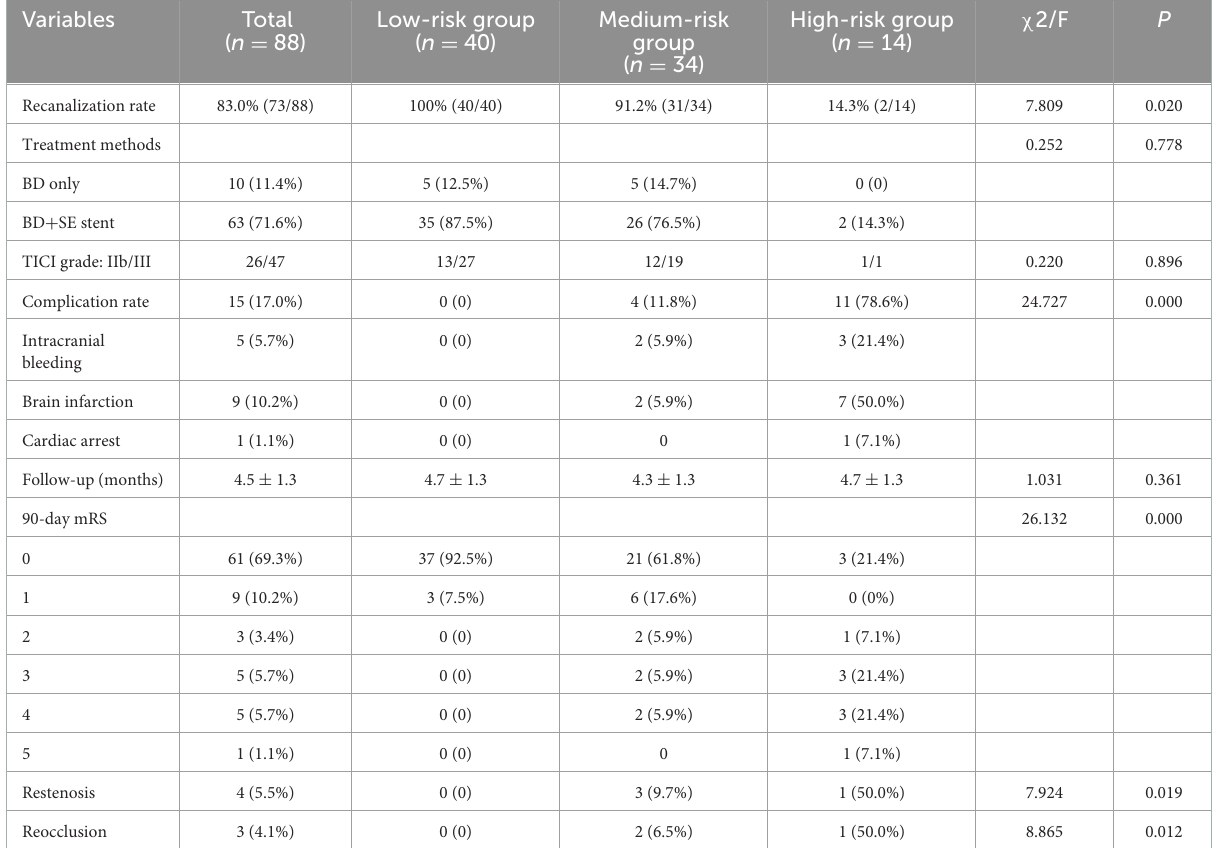
TABLE 3 Complications and clinical outcomes of 88 patients with